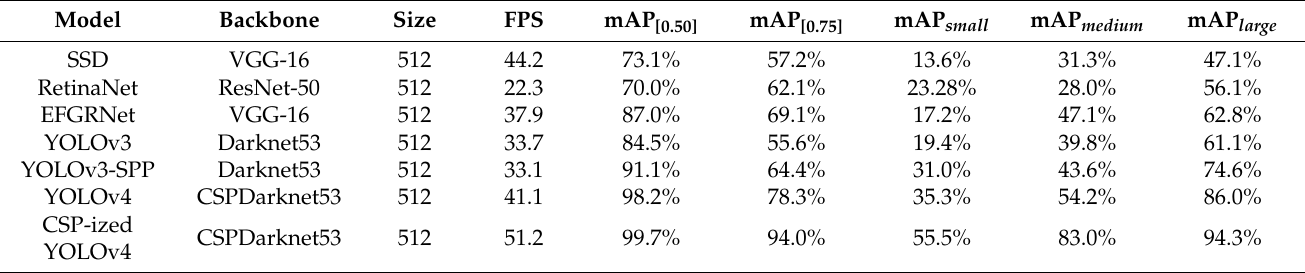
Table 1. Comparative analysis of one-stage object detectors on the ExDARK dataset at various thresholds.